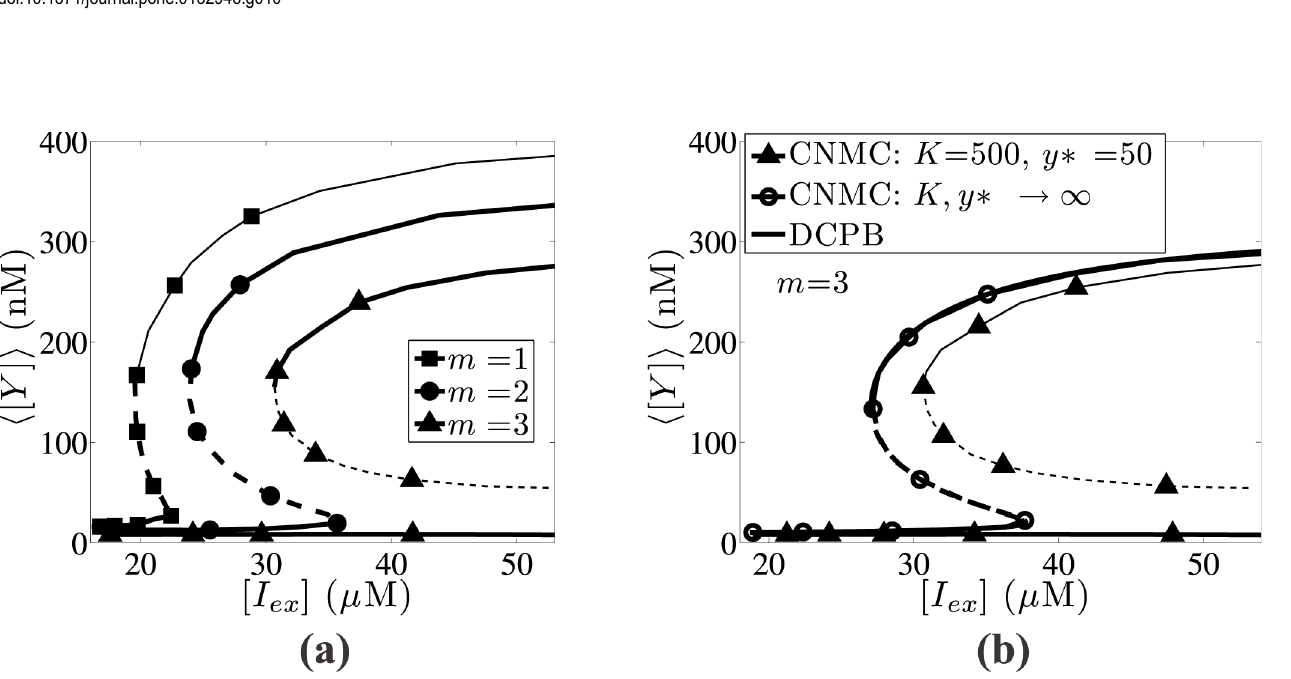
Fig 10. Effect of partitioning asymmetry parameter. Effect of the partitioning asymmetry parameter, f , in the average expression of lacY gene steady state ( h [ Y ] i ), as a function of the inverse IPTG concentration ([ I ex ]). (a) Lines with full circles correspond to symmetric partitioning ( f = 0.5); lines with full squares correspond to f = 0.4 and lines with full triangles to f = 0.3. (b) Comparison between the CNMC model neglecting intrinsic source of heterogeneity with f = 0.3 ( lines with open circles ), the DCPB model ( black lines (solid and dashed) ) and the CNMC incorporating intrinsic noise effects ( lines with full triangles ). Parameter set values: m = 2, π = 0.03 and κ = 0.05. CNMC simulations are performed with N = 10,000 cells.